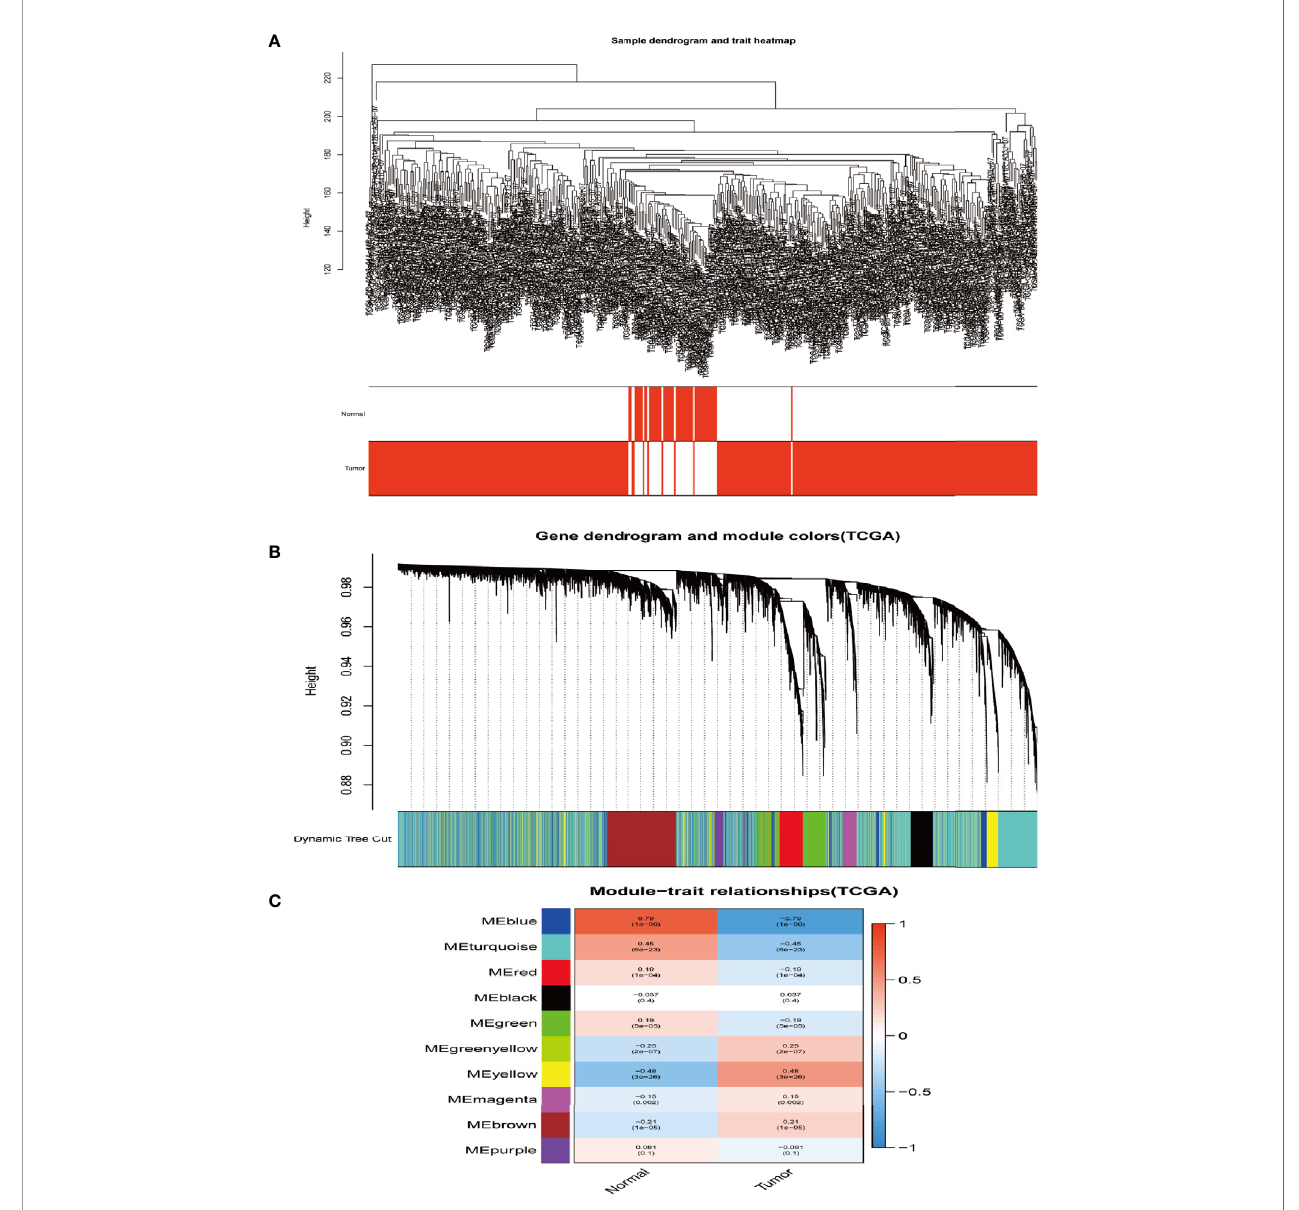
FIGURE 5 | Co-expression modules construction and selection in the TCGA dataset. (A) Samples clustering and trait heatmap. (B) Dendrogram of co-expression network modules were clustered with dissimilarity according to topological overlap (1-TOM). (C) Heatmap of the correlation between the module eigengenes (ME) and